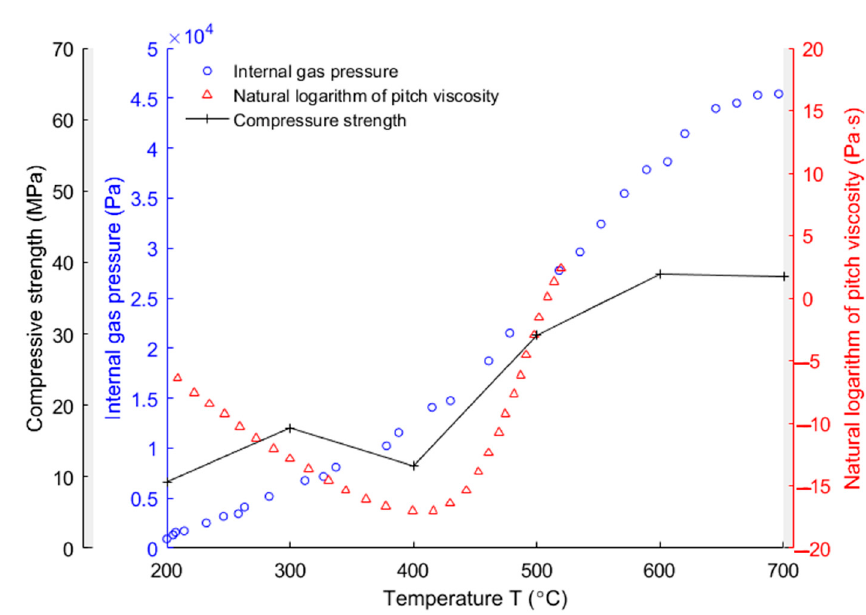
Figure 18. Internal gas pressure [30], natural logarithm of pitch viscosity [2] and compressive strength of the anode [37].